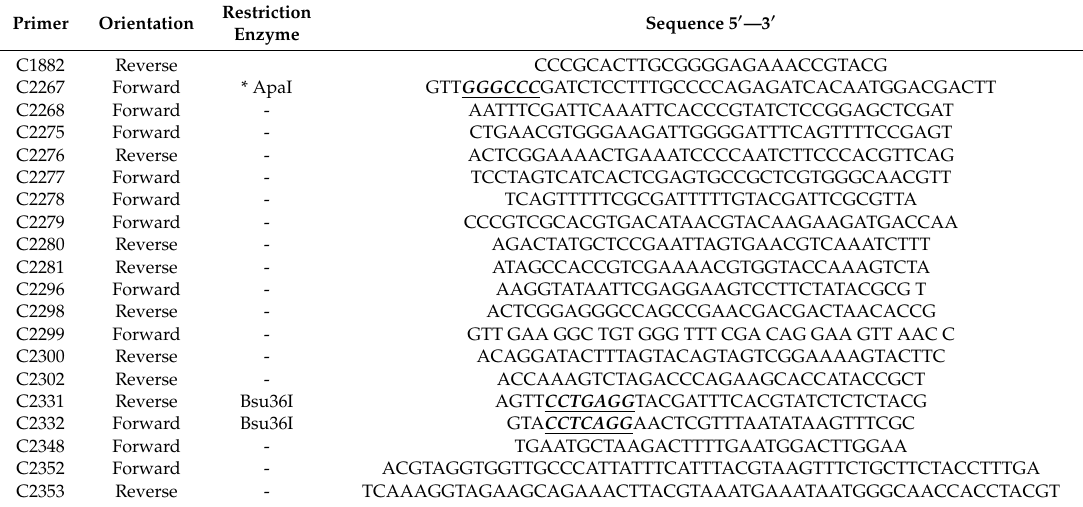
Table 1. List of primers used in building CTV infectious hybrid